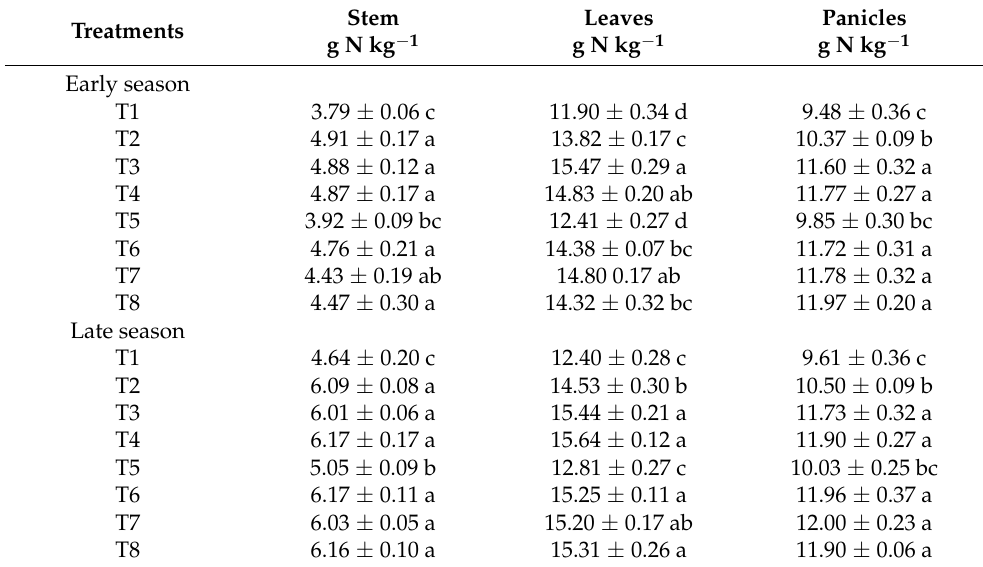
Figure 6. ( A , B ) Concentration of NOB in the early and late seasons under low ‐ and high ‐ dose urea application and different levels of biochar application. Note: Bars with different letters are significantly different, at p < 0.05. Table 3. Response of plant N accumulation to low- and high-dose urea application under different levels of biochar